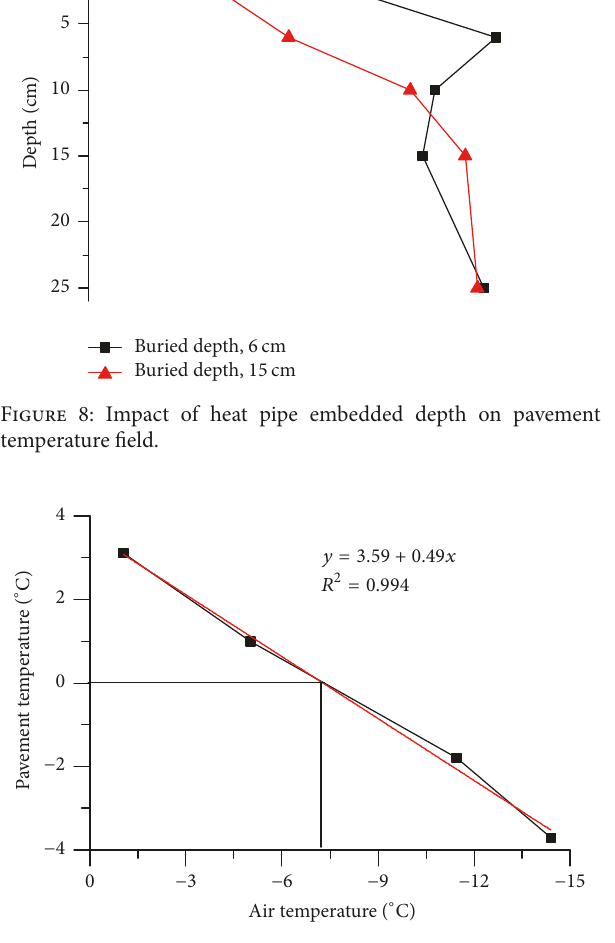
Figure 9: Impact of air temperature on pavement surface tempera- ture.